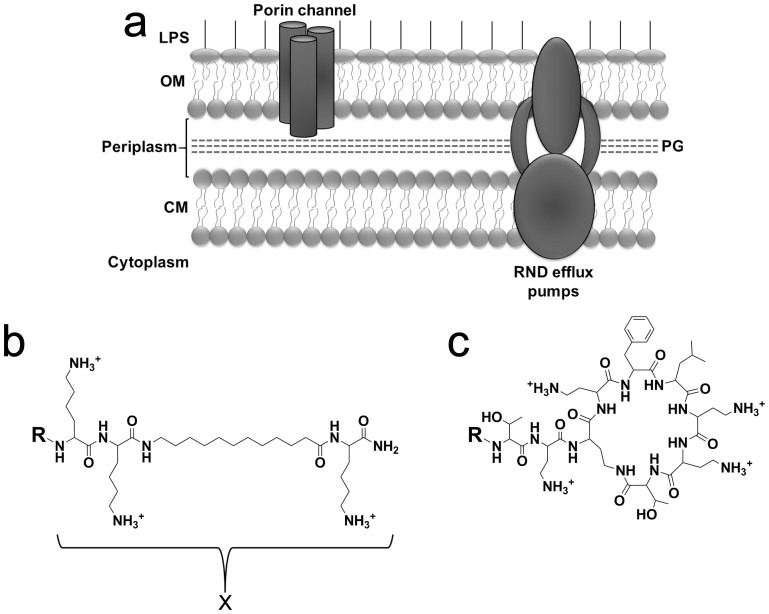
Structural features of bacterial cell wall and lipopeptides.(a) Typical double-membrane organization in Gram-negative bacteria. The outer membrane (OM) is composed of proteins bathing in lipids such as lipoplysaccharides (LPS) in the outermost layer and phospholipids in the inner layer whereas the cytoplasmic membrane (CM) is composed of phospholipids and proteins in both layers. The space between OM and CM (the periplasm) contains a thin peptidoglycan (PG) layer. The protein complex passing through both membranes represents a resistance-nodulation-division efflux pump. (b) Molecular structures of OAKs investigated, referred to as RX, where R is either H or one of the following acyls: octanoyl (C8), decanoyl (C10), dodecanoyl (C12) or its unsaturated version dodecenoyl (C12(ω7)) and X is the amino acid sequence lysyl-lysyl-aminododecanoyl-lysyl-amide (KKc12K). (c) Structure of polymyxin where R is 6-methyloctanoyl-diaminobutiroyl or H, for the native polymyxin B and nonapeptide derivative, respectively.